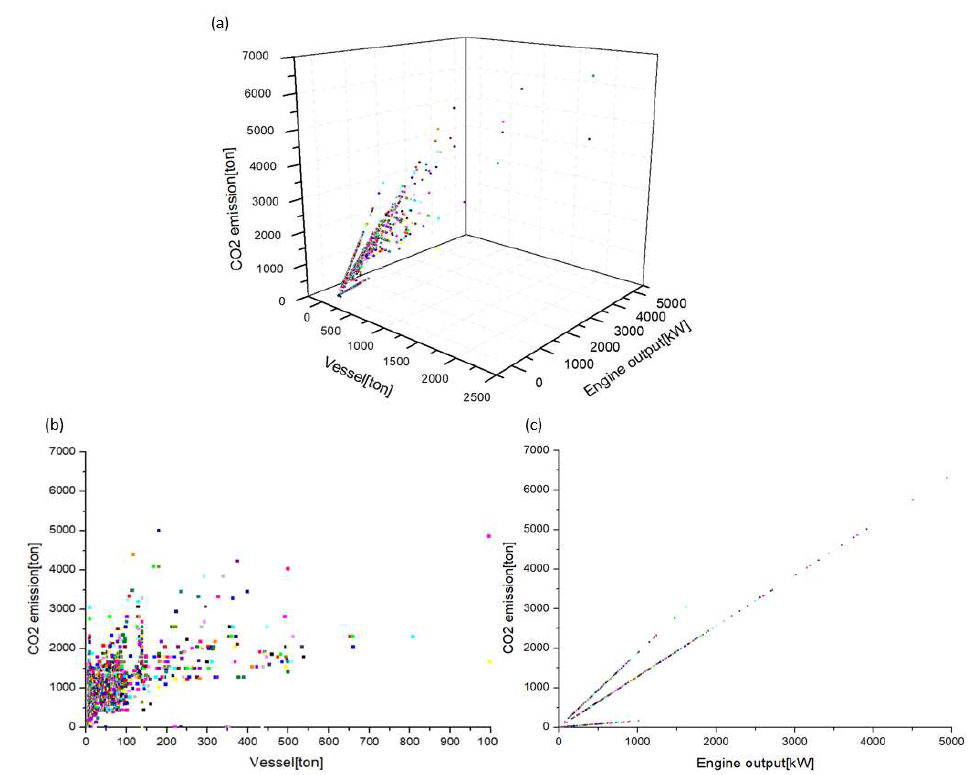
Figure 9. Carbon dioxide emissions according to the tonnage and output of fishing boats: ( a ) an- nual carbon dioxide emissions compared to the tonnage and engine output in fishing ships; ( b ) carbon dioxide emissions by tonnage; ( c ) annual carbon dioxide emissions by engine output. put.